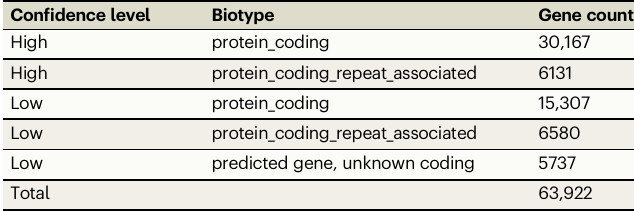
Table 1 | Annotation biotype and gene con fi dence assignment for L. sativus LS007 genome